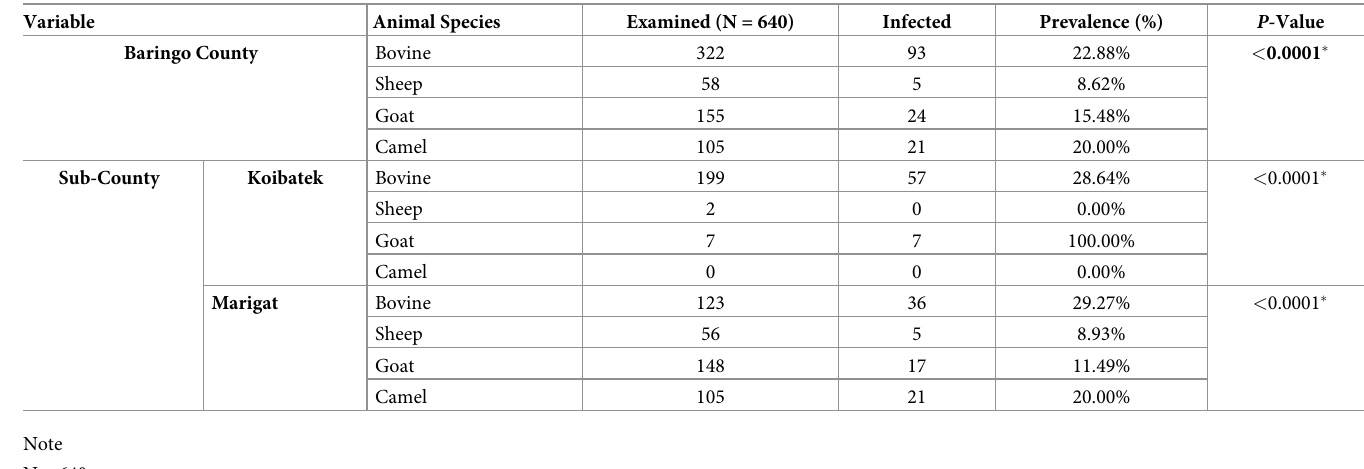
Table 3. Sero-prevalence of brucellosis in domestic ruminants (bovine, sheep, goat and camels) among Koibatek and Marigat sub counites in Baringo County. Variable